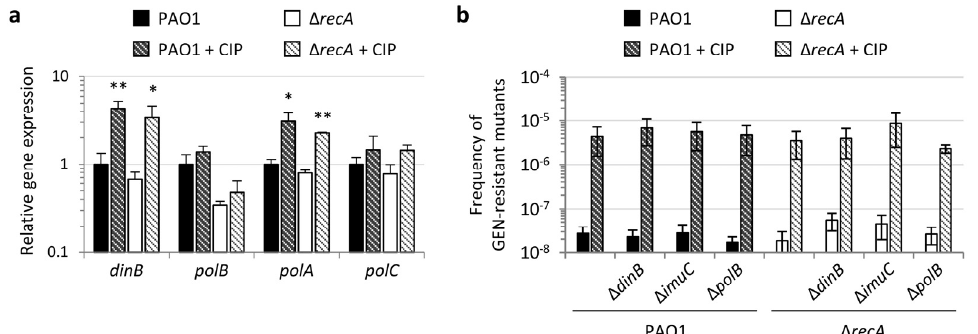
Figure 3. Specialized DNA polymerases are not required for fluoroquinolone-induced mutagenesis in P. aeruginosa . ( a ) Relative mRNA levels of the DNA polymerase genes dinB , polB , polA , and polC , determined by qRT-PCR, in P. aeruginosa PAO1 and the Δ recA mutant cultured in MH in the absence or in the presence of 0.25 × MIC ciprofloxacin (CIP) (0.031 and 0.008 µ g/mL for PAO1 and ∆ recA , respectively; Table 1). Values are the mean ( ± SD) of three independent experiments. Asterisks indicate a statistically significant difference in the frequency of mutants with respect to the corresponding untreated control (unpaired t test: * p < 0.05; ** p < 0.01). ( b ) Frequency of gentamicin (GEN) resistant mutants obtained on agar plates containing GEN at 20 × MIC for P. aeruginosa PAO1, the Δ recA mutant, and the cognate polB , dinB , and imuC mutants. Strains were precultured in MH at 37 °C in the absence or in the presence of CIP at 0.25×MIC. Values are the mean (± SD) of four independent experiments. No statistically significant differences between strains were observed under the same experimental condition (absence or presence of CIP in the preinoculum).